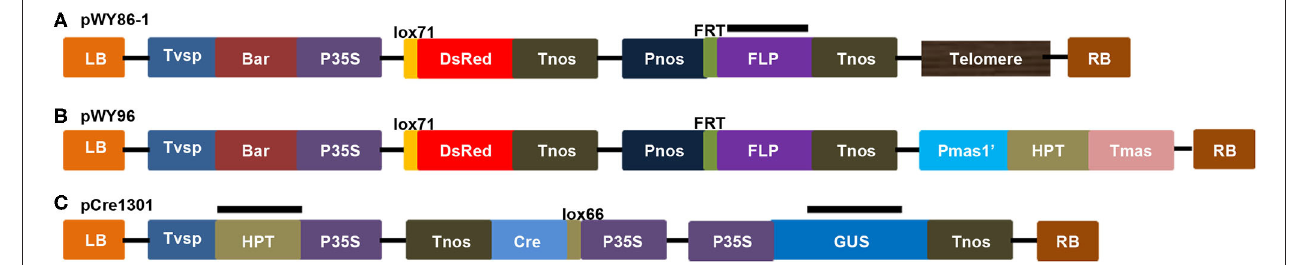
FIGURE 1 | Constructs of pWY86-1, pWY96, and pCre1301. (A) Construct pWY86-1 derived from pWY86 (Yu et al., 2006), containing Arabidopsis telomeric sequence and promoter-less lox71-DsRed. (B) The contrasting construct pWY96 (Yu et al., 2006) was used as a FISH probe to detect transgenes from pWY86-1 transformations. (C) Construction of pCre1301 containing the P35S-lox66-Cre-Tnos expression cassette. The screening marker genes in plants are HPT and GUS. LB, T-DNA left border; RB, T-DNA right border; Tvsp, terminator from soybean vegetative storage protein gene; Bar, bialaphos resistance gene as a selection marker gene; P35S, 35S promoter from cauliflower mosaic virus; Tnos, Nos terminator from Agrobacterium ; Tmas, Mas terminator from Agrobacterium ; Pnos, Nos promoter from Agrobacterium ; Pmas1’, Mas promoter from Agrobacterium ; lox and FRT, site-specific recombination sites; HPT, hygromycin B-resistance gene as a selection marker gene; DsRed, red fluorescent protein gene; FLP, recombinase gene; Cre, recombinase gene; GUS, uidA gene; lox71, the lox71 site; lox66, the lox66 site; Telomere, telomere units of pAtT4 isolated from Arabidopsis thaliana . The black bars showed the targeted region by PCR for checking T-DNA integrity using primers FLP_F, FLP_R, GUS_F, GUS_R, HPT_F and HPT_R ( Supplementary Figure 1 and Supplementary Table 1